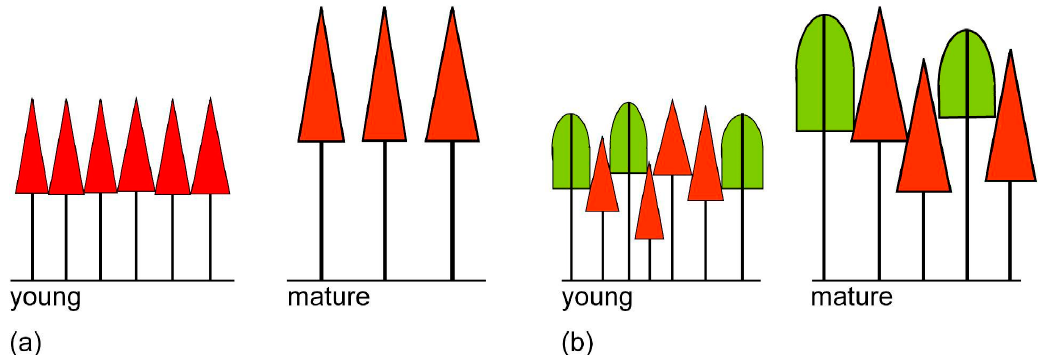
Figure 6. In even-aged monospecific stands ( a ) the crowns are similar and in the same layer. This can restrict the crown expansion in young stands and may cause mechanical abrasion and crown shyness in mature stands. In mixed-species stands; ( b ) the crowns’ space to grow may be less restricted and the crown size less reduced by mechanical abrasion. The crowns are often arranged in different layers in both young and mature stands.